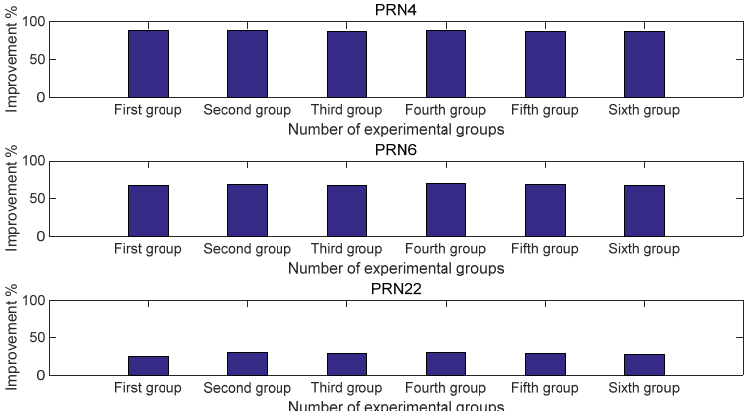
Figure 8. The running time of two methods for PRN 4, PRN 6 and PRN 22. Table 2. STD values of the processing times of selected satellites using the two methods.